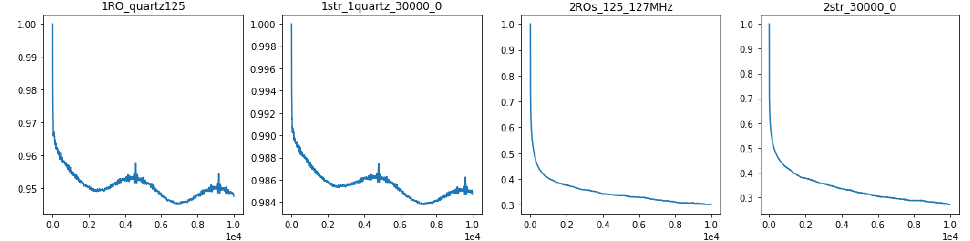
Figure 16: Autocorrelations of counter values, small lags (bias-corrected estimate ˆ ρ u )